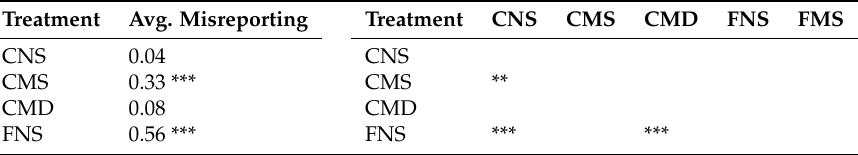
Table A5. Misreporting of Type M Patients across experimental conditions.